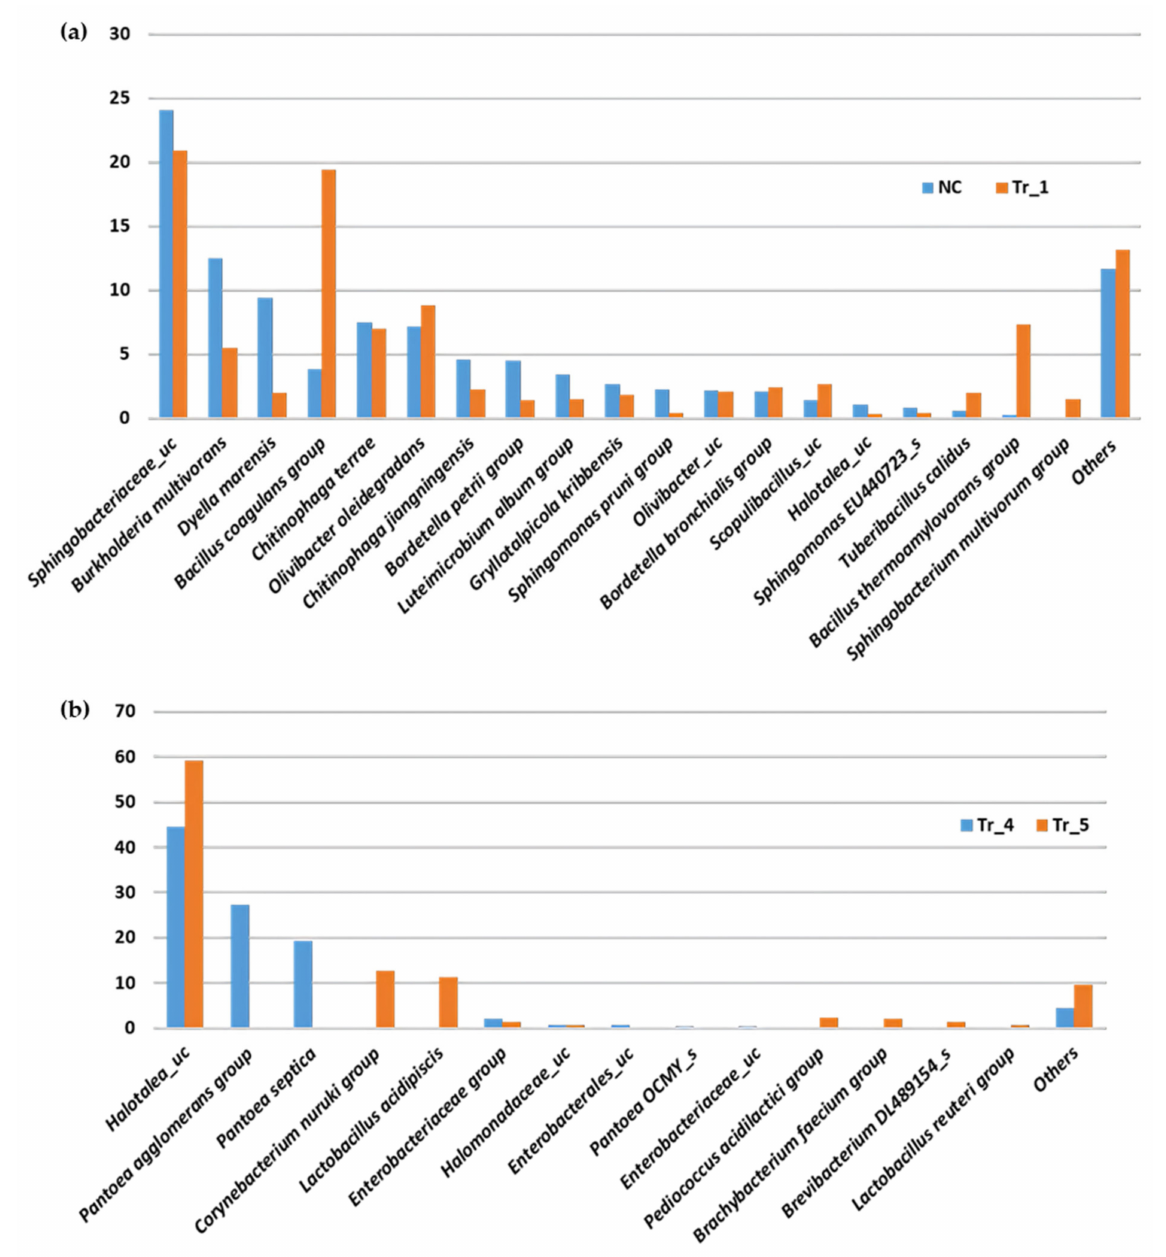
Figure 6. Microbial community structures of the representative functional composts. ( a ) Laboratory scale; ( b ) Pilot